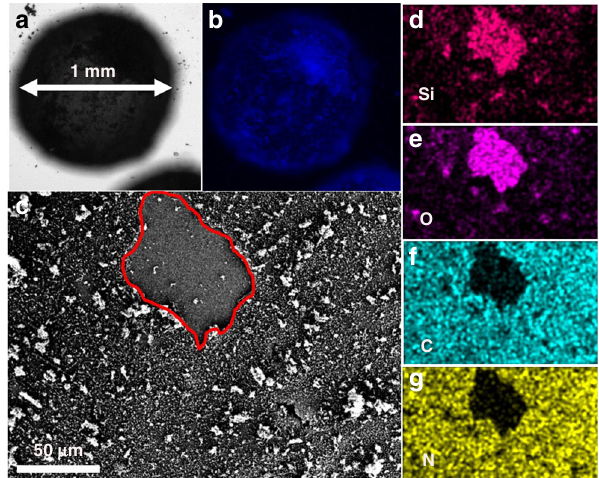
Fig. 4 Fluorescence and SEM images of UCN@glass beads. a Optical microscope image and b fl uorescence image with scale of 1 mm. c SEM image (the red marking region is a man-made removal of carbon nitride to distinguish the surface of UCN and glass beads). d – g Element mapping images. Elements from top to bottom are Si, O, C, and N,